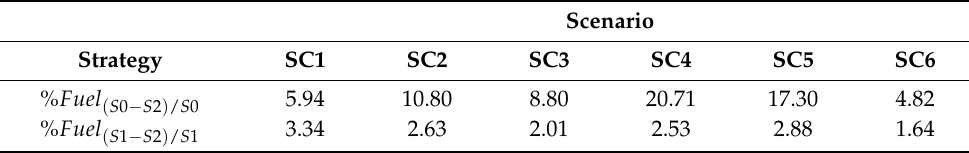
Table 5. Percentage decrease in fuel consumption (% Fuel ( S 0 − S 2 ) / S 0 and (% Fuel ( S 1 − S 2 ) / S 1 ) under different scenarios used to test the performance of the PV/FC/ESS